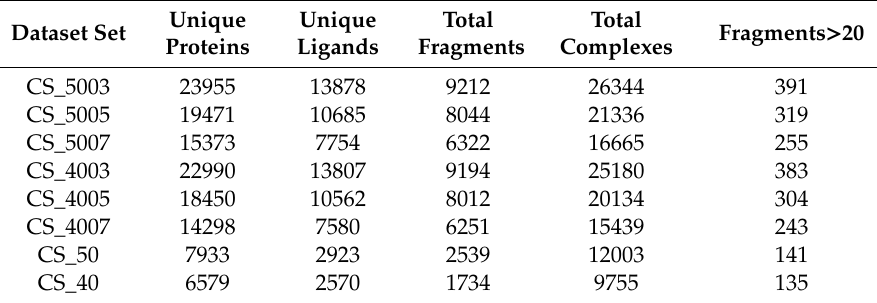
Table 2. Datasets’ composition.